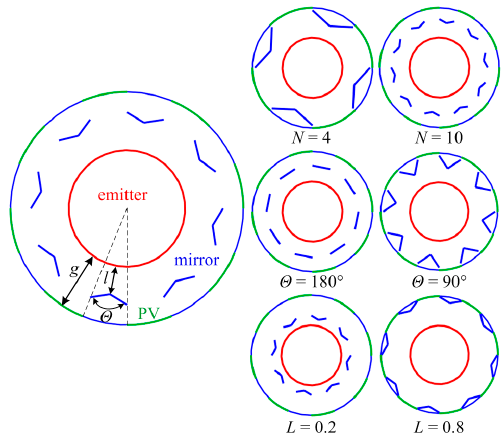
Figure 9. Schematics and the changed variables of configuration 3.